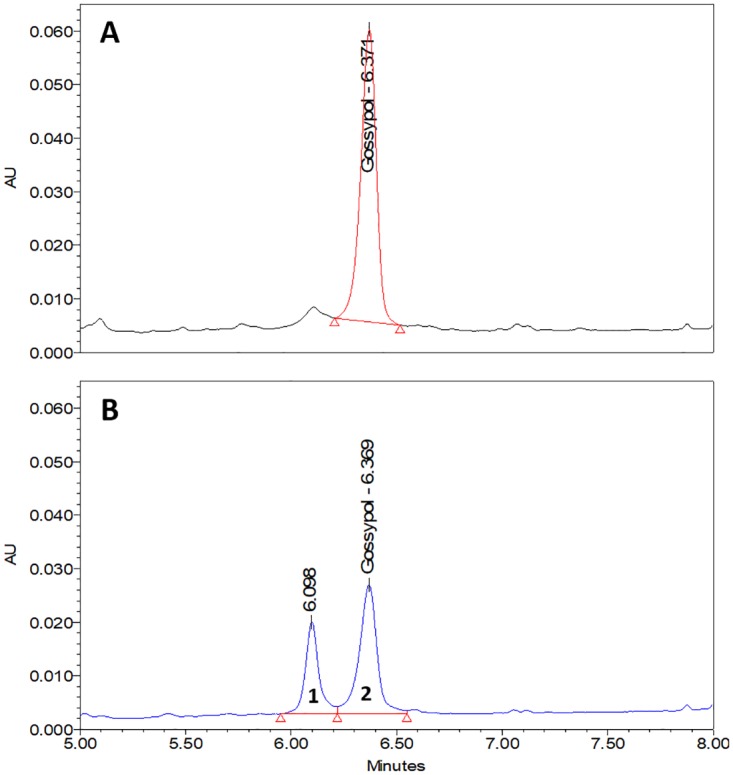
UHPLC chromatograms of free gossypol (FG) extracted from cottonseed cake (CSC) using different acetone concentrations.Identical gradient elution conditions and extraction conditions with sonication on ice were applied throughout. For both samples, 1g CSC were spiked with 80 μL of a 5 mg/mL gossypol solution. (A) Extraction with 70% acetone (peak area = 282558); (B) extraction with 100% acetone (peak 1 area = 142704, peak 2 area = 77803).